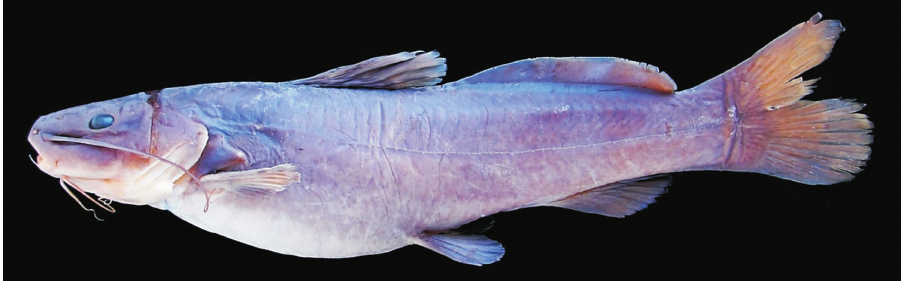
Fig. 2. Lateral view of Rhamdia branneri , LISDEBE 5534, 228.5 mm SL, Brazil, Paraná, rio Timbó, Colônia São Pedro.